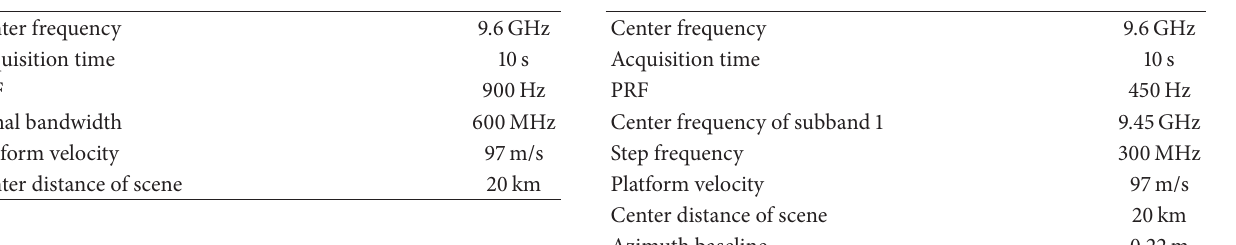
Table 3: Main system parameters of original data. Table 4: Main system parameters of constructed